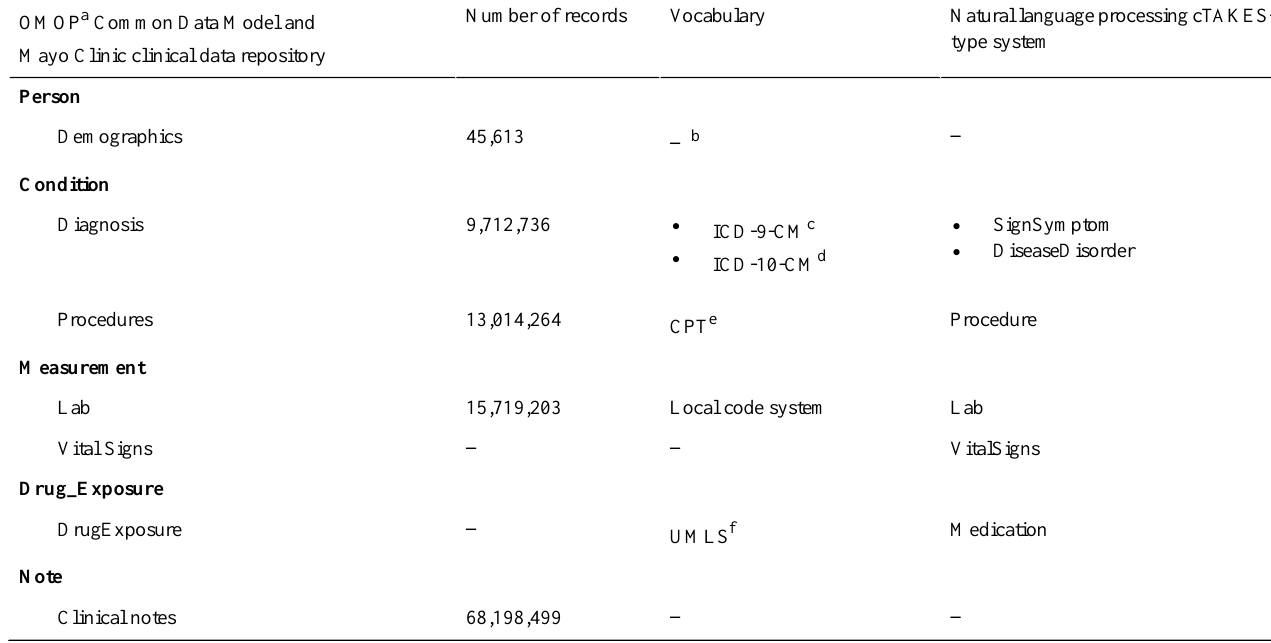
Table 1. Table-level mapping between OMOP Common Data Model and Mayo Clinic electronic health records.